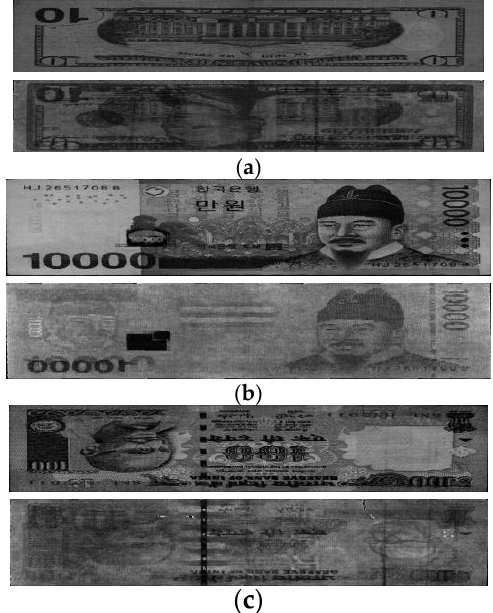
Figure 13. Examples of incorrectly recognized cases (Type II error) by our method on: ( a ) USD; ( b ) KRW; ( c ) INR. In (a–c), upper and lower figures represent the VR and NIRT images, respectively.